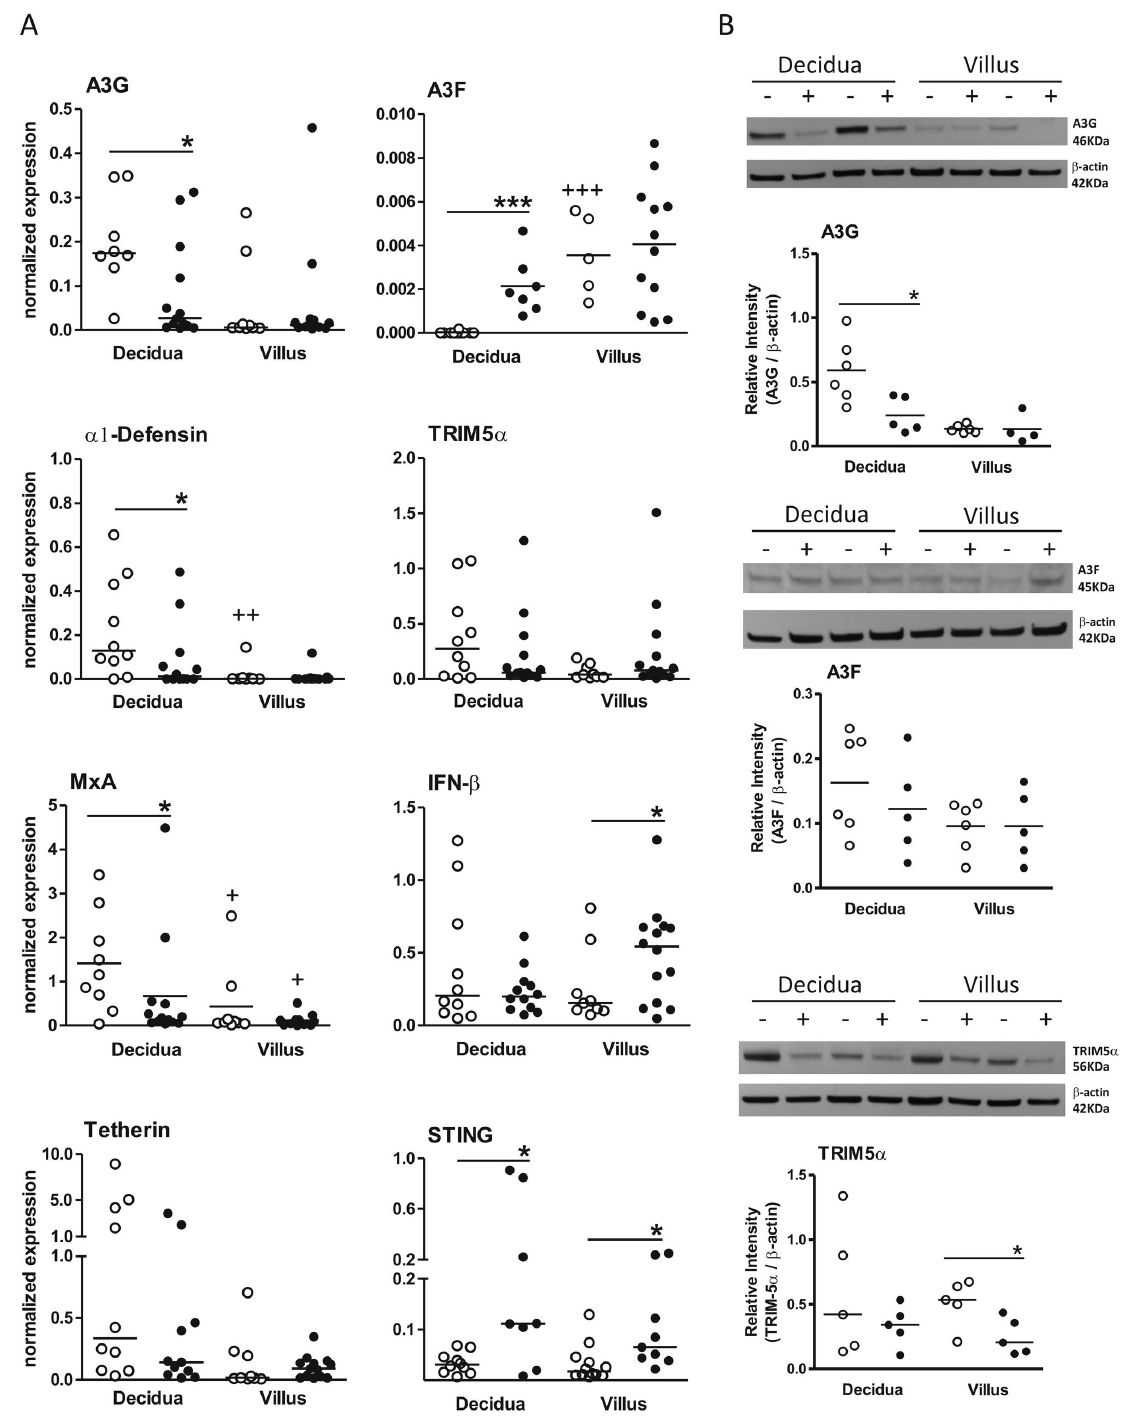
Figure 2. Differential expression of antiviral factors in the placental tissues of HIV-infected mothers and CB samples. A) Decidua (n=10-13) and placental chorionic villi (n=9-13) from HIV-infected mothers (closed symbols) and UN mothers (open symbols) were assessed for A3G, A3F, TRIM-5α, α1-defensin, IFN-β, tetherin and STING expression using real-time PCR. The data represent median values. B) Immunoblot analysis of A3G, A3F and TRIM5α protein in decidua (n=5-6) and villi (n=4-6) from infected mothers (+, closed symbols) and UN mothers (-, open symbols). The data represent median values.*p≤0.05 compared with the control group; ++p≤0.01 compared with the mother group. doi: 10.1371/journal.pone.0084917.g002 PLOS ONE |